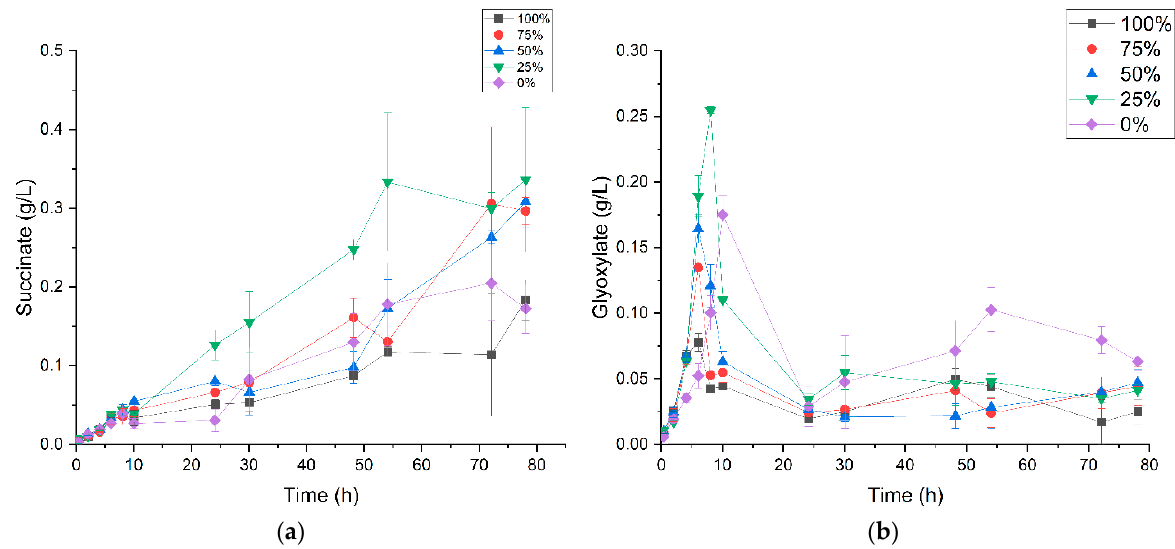
Figure 7. Concentrations of ( a ) succinate and ( b ) glyoxylate during growth of P. thermoglucosidasius DSM 6285 under different initial carbon monoxide atmospheres (0, 25, 50, 75 and 100% CO). Glyoxylate reached maximum concentration at ~10 h when ~50% of the initial O 2 was consumed while succinate accumulates during the cultivation. Reported values represent means of triplicate experiments ± standard deviation.